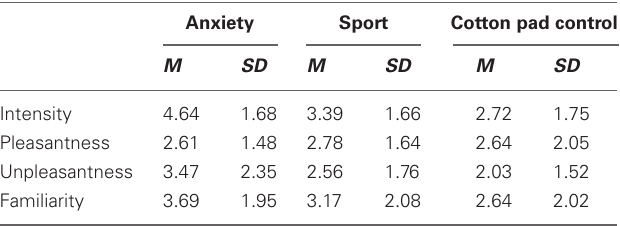
Table 3 | Mean intensity, pleasantness, unpleasantness, and